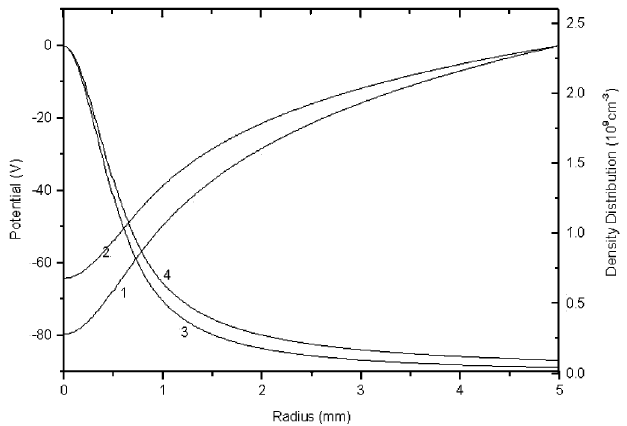
FIG. 3. Potential and ion distribution vs radius. Line 1: the potential distribution without including the effect of positively charged ions; line 2: the potential distribution including the effect of positively charged ions; line 3: the ion density distri- bution with the potential distribution 1; line 4: the ion density distribution with the potential distribution